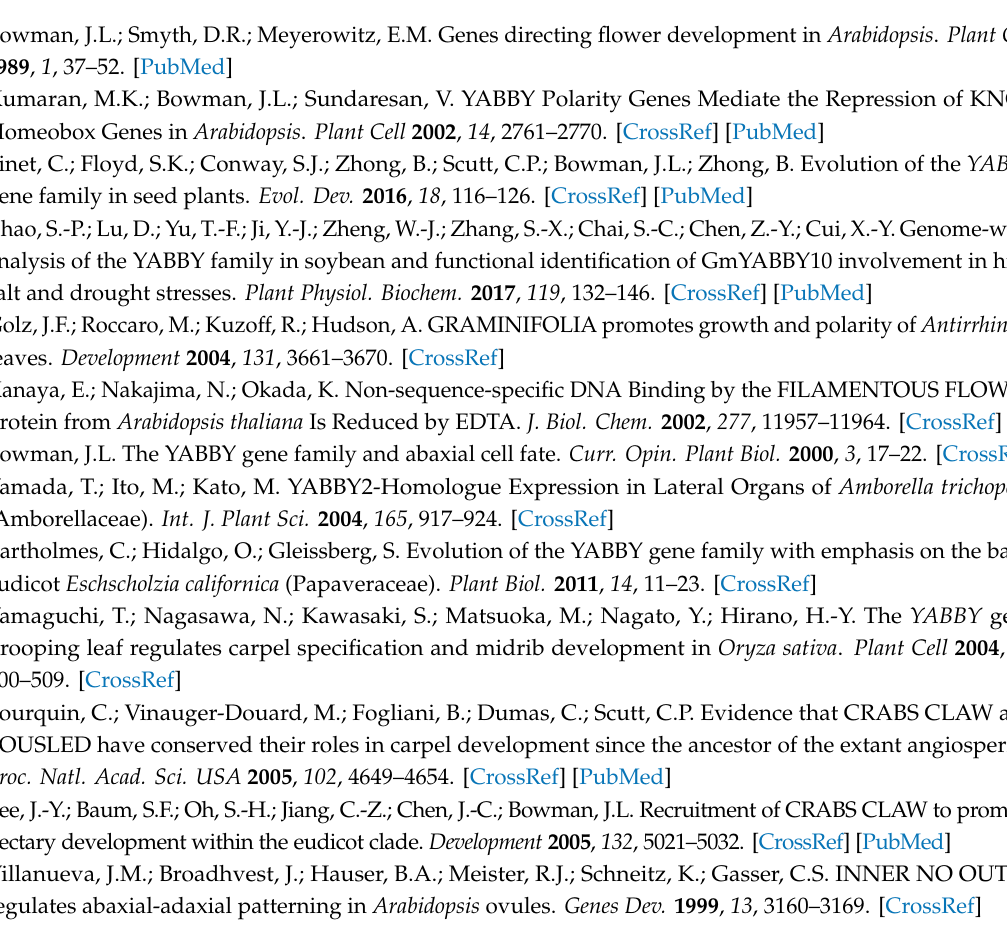
Supplemental Figure S1: Conserved C2C2 zinc-finger and YABBY domains of YABBY proteins among A. thaliana and eight orchid species. Supplemental Figure S2: Multiple sequence alignment of the CRC / DL-related protein among eight orchid species. Supplemental Figure S3: Multiple sequence alignment of the INO-related protein among eight orchid species. Supplemental Figure S4: Multiple sequence alignment of YAB2-related protein among eight orchid species. Supplemental Figure S5: Multiple sequence alignment of the FIL-related protein among eight orchid species. Supplemental Figure S6: Phylogenetic tree of the CRC / DL protein from the angiosperms. Supplemental Figure S7: Quantitative real-time PCR analysis of the expressions of PeYABBY genes in P. aphrodite subsp. formosana at various organs. Supplemental Figure S8: Quantitative real-time PCR analysis of the expressions of PeYABBY genes in P. aphrodite subsp. formosana at various ovule developmental stages. Figure S9: Expression patterns of YABBY genes in di ff erent tissues of Apostasia , Dendrobium , and Phalaenopsis . Supplemental Table S1: YABBY-related genes in the phylogenetic tree and protein alignments. Supplementary Table S2: List of primers used in this